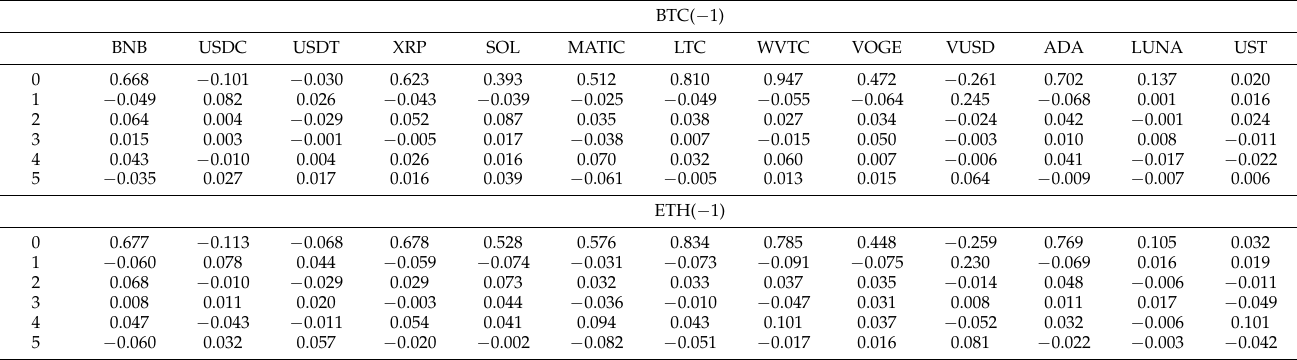
Table A3. Cryptocurrencies